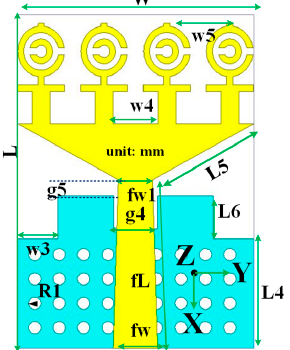
Figure 4. The reported metamaterial (MTM) antenna layout. Table 3. Antenna design parameters according to Figure 4.